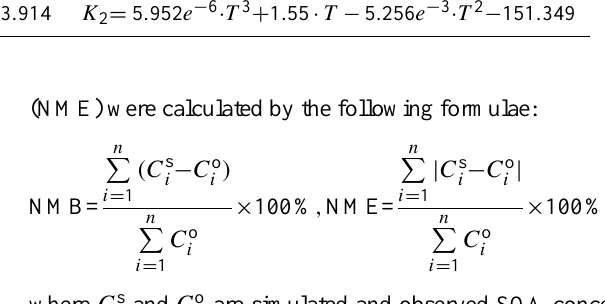
Table 3b. The unified temperature parameterized functions K(T ) for gas-particle partitioning coefficient ( K ). species K 1 K 2 α -pinene